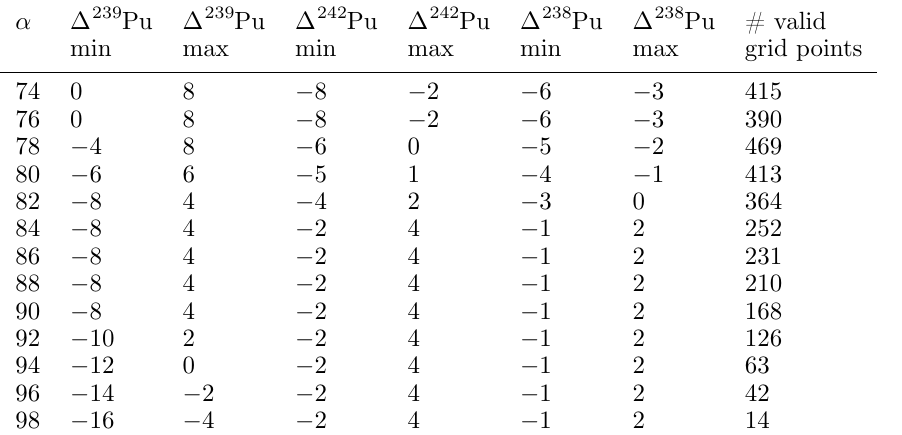
Table 3. Grid boundary values determined from the flyspecks. The number of valid (i.e. all components positive) Pu vectors per value of α is given in the last column.